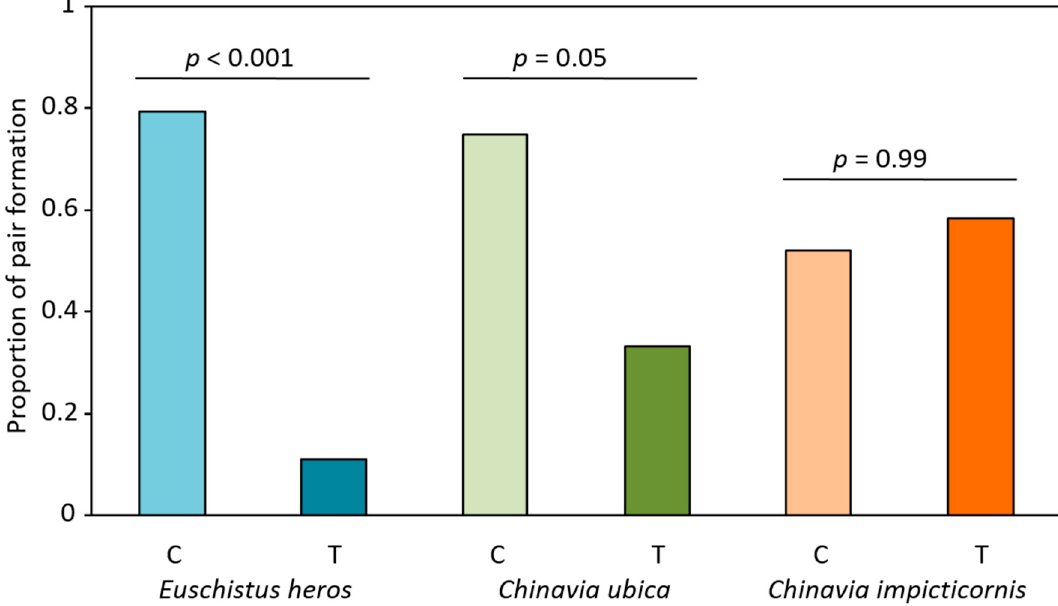
Figure 4. Effect of conspecific female rival signals on the pair formation (insects on the same leaf of the plant and in physical contact) of three stink bug species. Proportion of pair formation (individuals copulating/individuals emitting vibratory signals of Euschistus heros , Chinavia ubica and Chinavia impicticornis when they were placed on control (non-vibrated—C) or treatment (vibrated with conspecific rival female signals—T). Significant differences were established by z-test for two proportions with continuity corrections. N = Euschistus heros C = 29, T = 27, Chinavia ubica C = 20, T = 12, Chinavia impicticornis C = 23, T = 12.